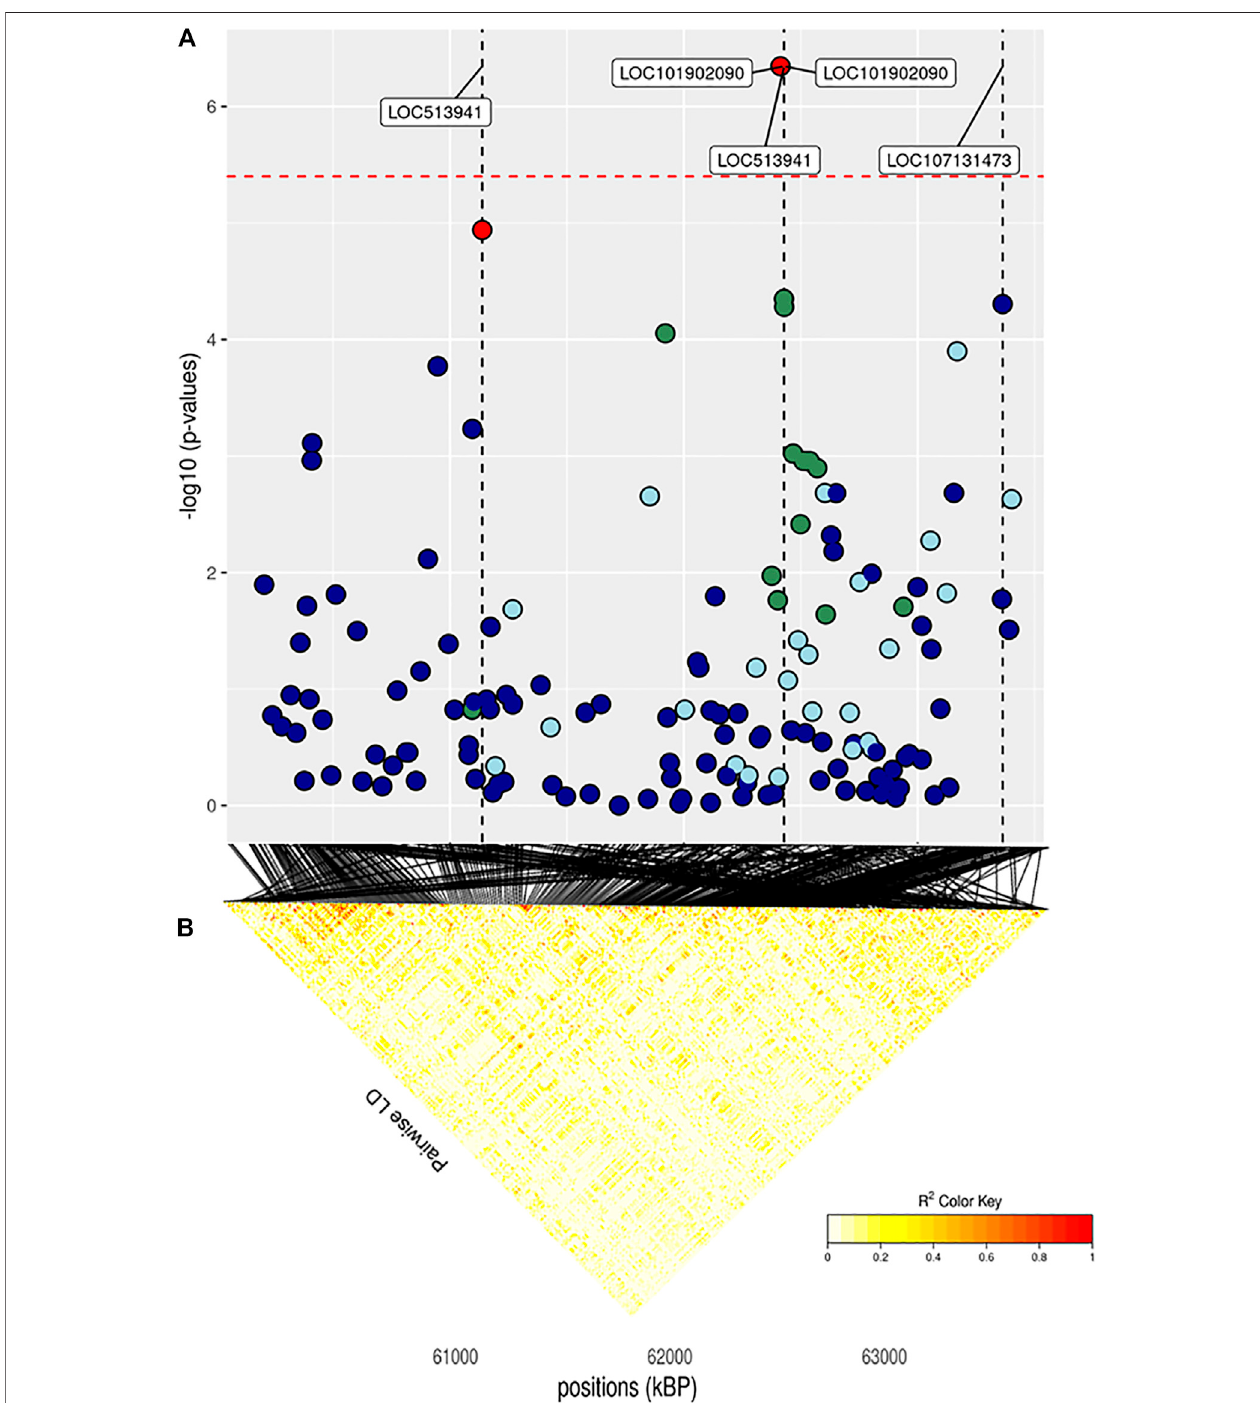
FIGURE 7 | (A) Localized linkage disequilibrium analysis of CF. Manhattan plots displaying the level of signi fi cance (y-axis) over genomic positions (x-axis) in a window of 0.5 Mb upstream and downstream of the most signi fi cantly SNP. Vertical line represents the position of candidate genes LOC513941 , NLRP2 and LOC107131373 . Differentcolorsare used torepresent the pairwise LD with the closest signi fi cant SNPs: blue < 0.2; light blue < 0.4; green < 0.6; yellow < 0.8 and red > 0.8. (B) the represents Linkage disequilibrium present of that area.